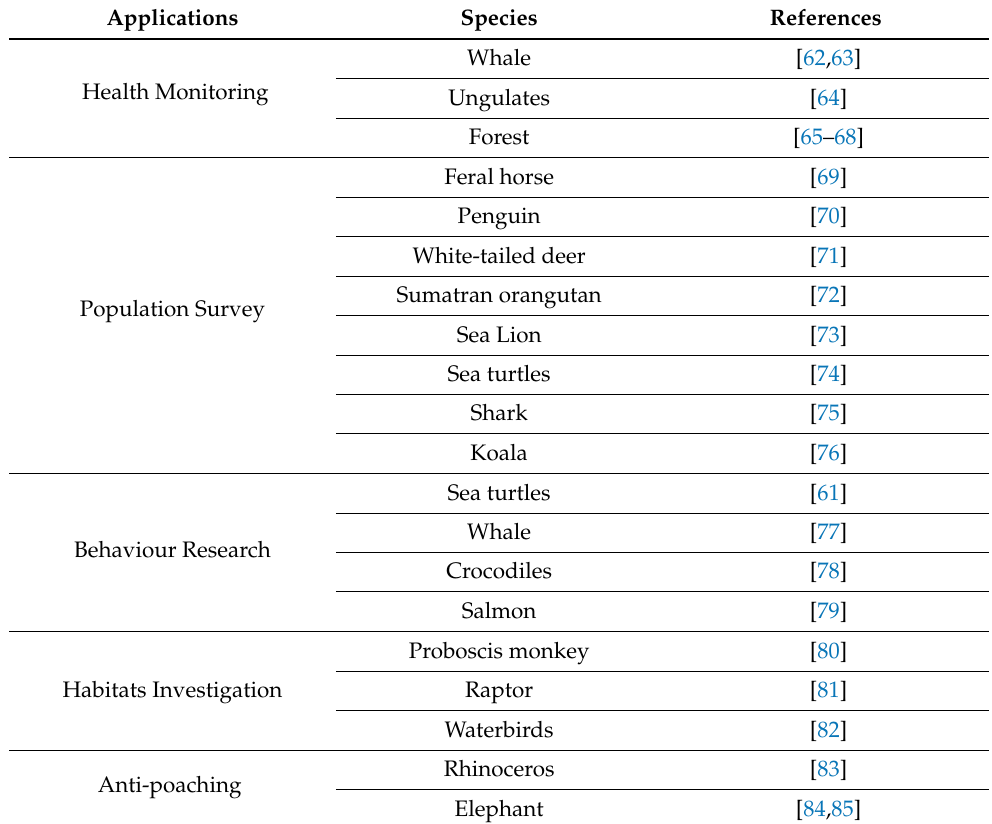
Table 1. Summary of existing publications on wildlife-monitoring